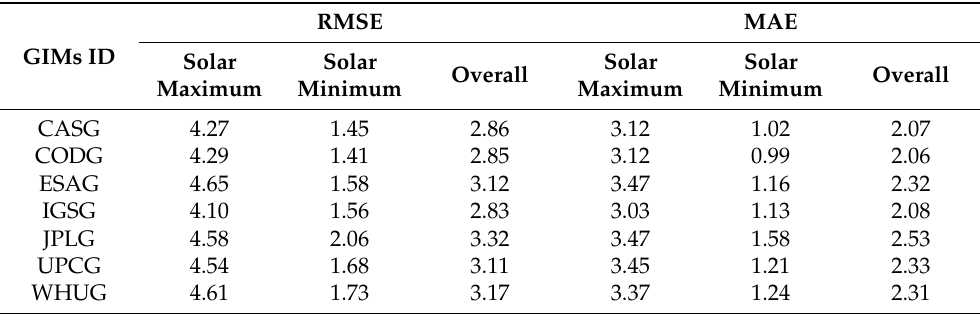
Table 4. RMSE and MAE values between the predicted TEC maps (using the TEC maps of the corre- sponding source as input) and the different TEC maps released by different IAACs in 2014 and 2018. RMSE MAE GIMs ID Solar Solar Solar Solar Overall Maximum Minimum Maximum CASG